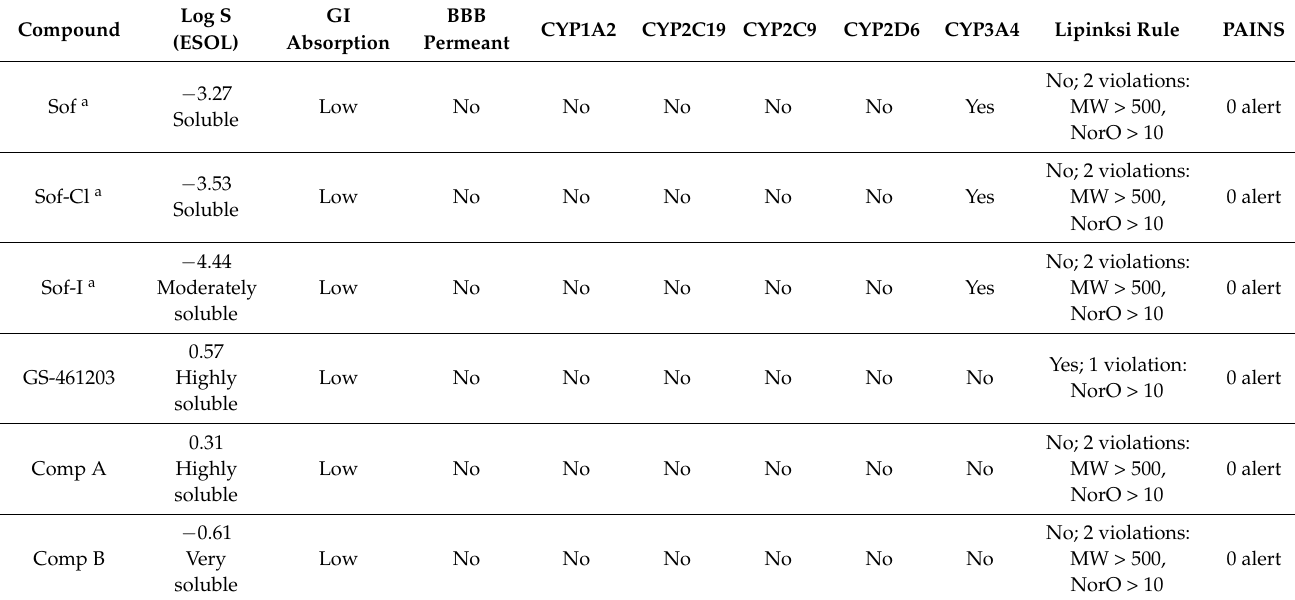
Table 4. The ADME properties of compounds predicted by